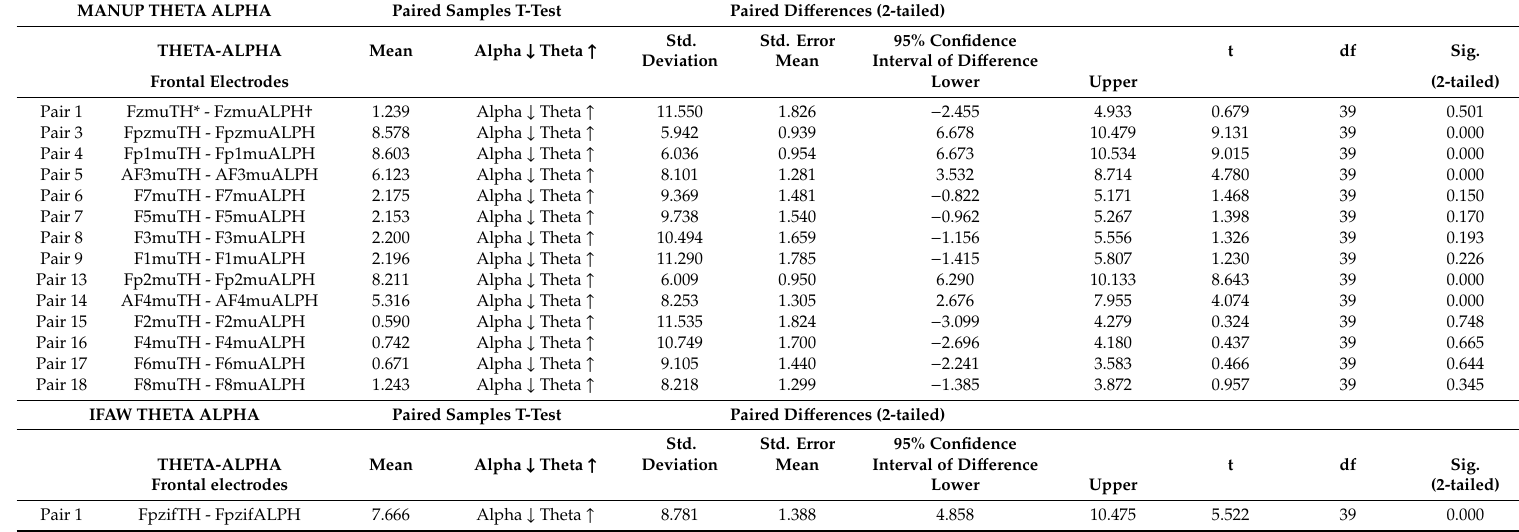
Table A2. Two tailed t-test theta average results for ManUp, IFAW, and Agilis showing Alpha ↓ Theta ↑